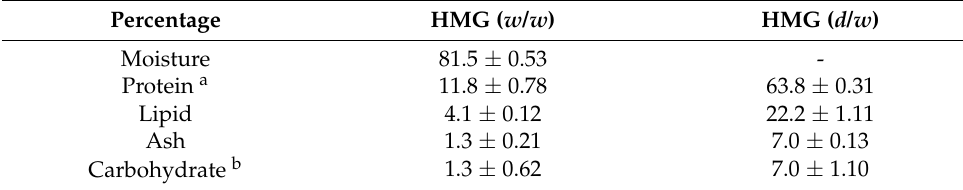
Table 1. Proximate composition of HMG. Percentage HMG ( w/w